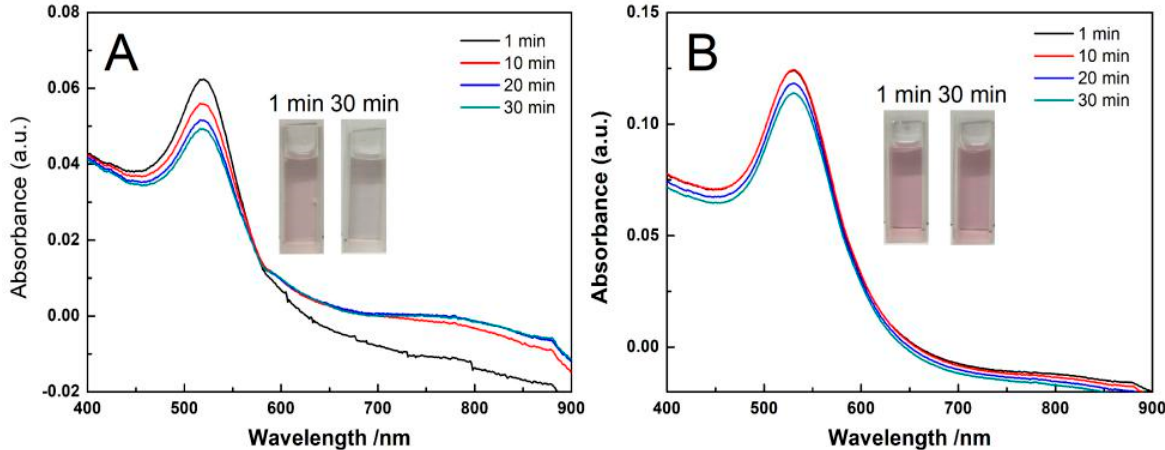
Figure 11. The change in UV-Vis spectra with time for AuNPs ( A ) and Au-PNIPAM ( B ) in 0.025 mM of CTAB solution.